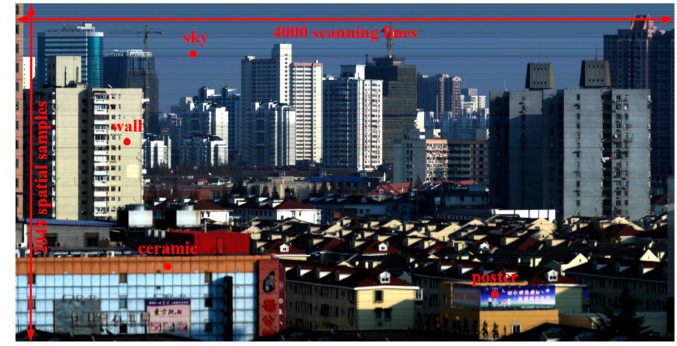
Figure 5. RGB image in visible bands from Camera 1 (R: 650 nm, G: 560 nm, B: 480 nm).